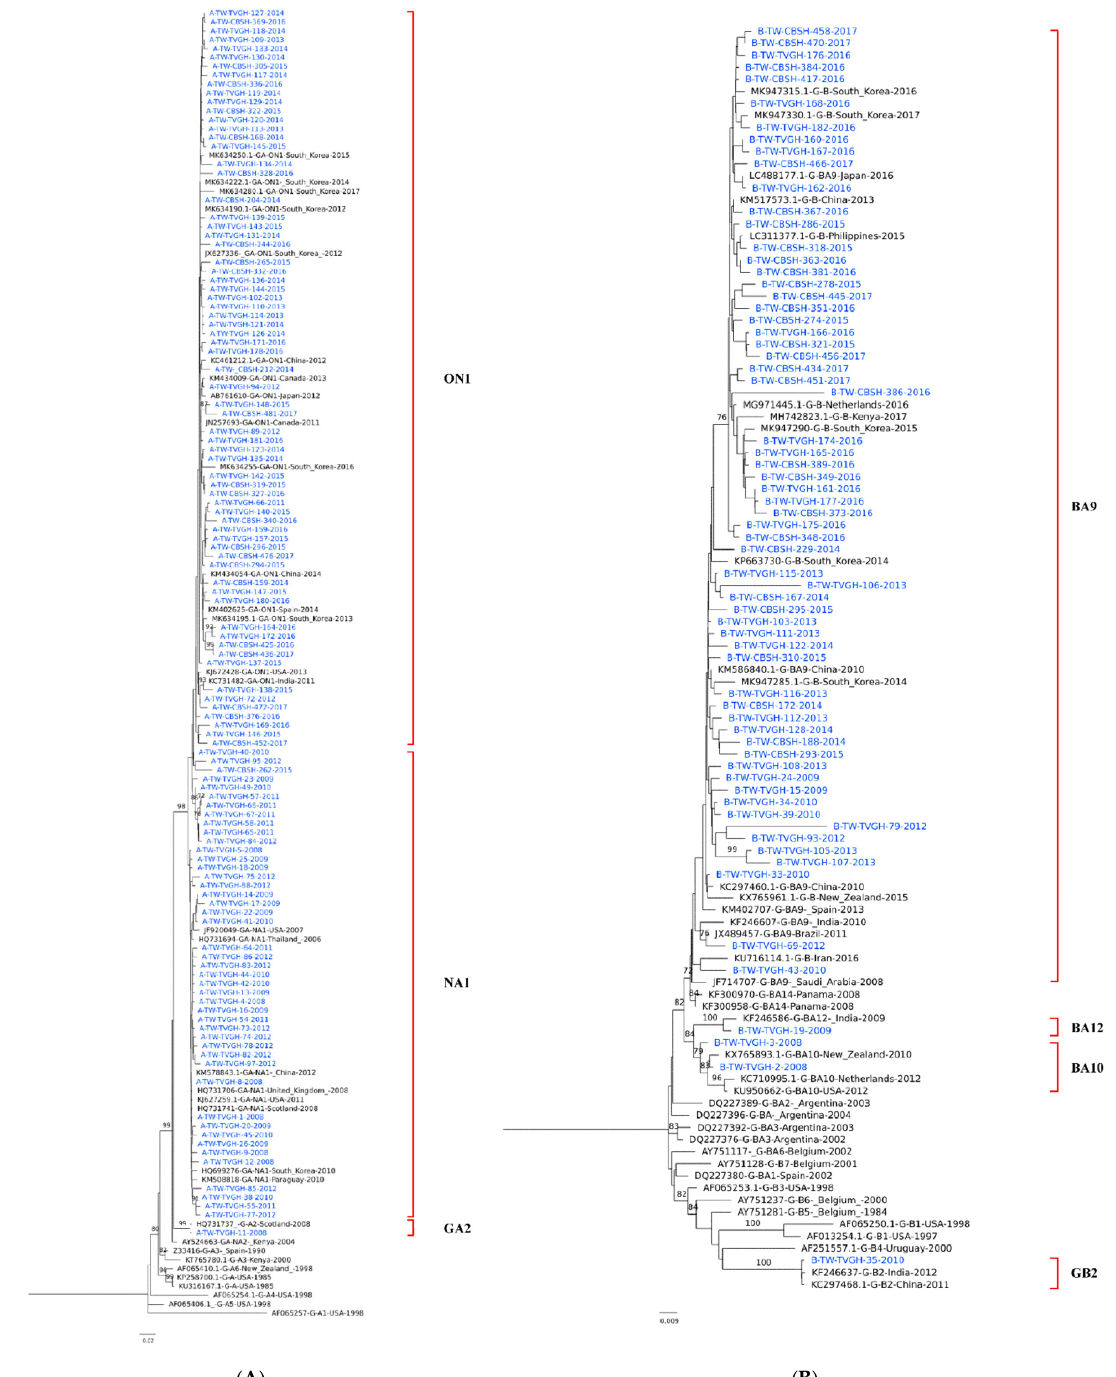
(Figure 1A). The Taiwanese NA1 and ON1 strains shared a high bootstrap value with strains from other countries, and the average p-distance within NA1 and ON1 in the cluster was 0.0015 and 0.0016, respectively, with a mean distance between the two being 0.0022.